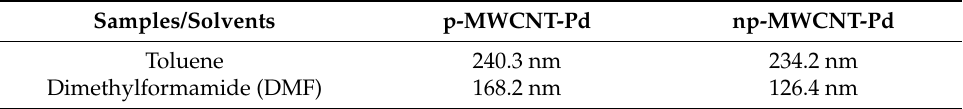
Figure 3. Photographs of different dispersions: ( a ) np-MWCNT-Pd dispersed in DMF, ( b ) p-MWCNT-Pd dispersed in DMF, ( c ) np-MWCNT-Pd in Toluene, ( d ) p-MWCNT-Pd in Toluene; ( e ) Pd/C dispersed in DMF, ( f ) Pd/C dispersed in Toluene. Table 1. Particle size of dispersible CNT-NM.